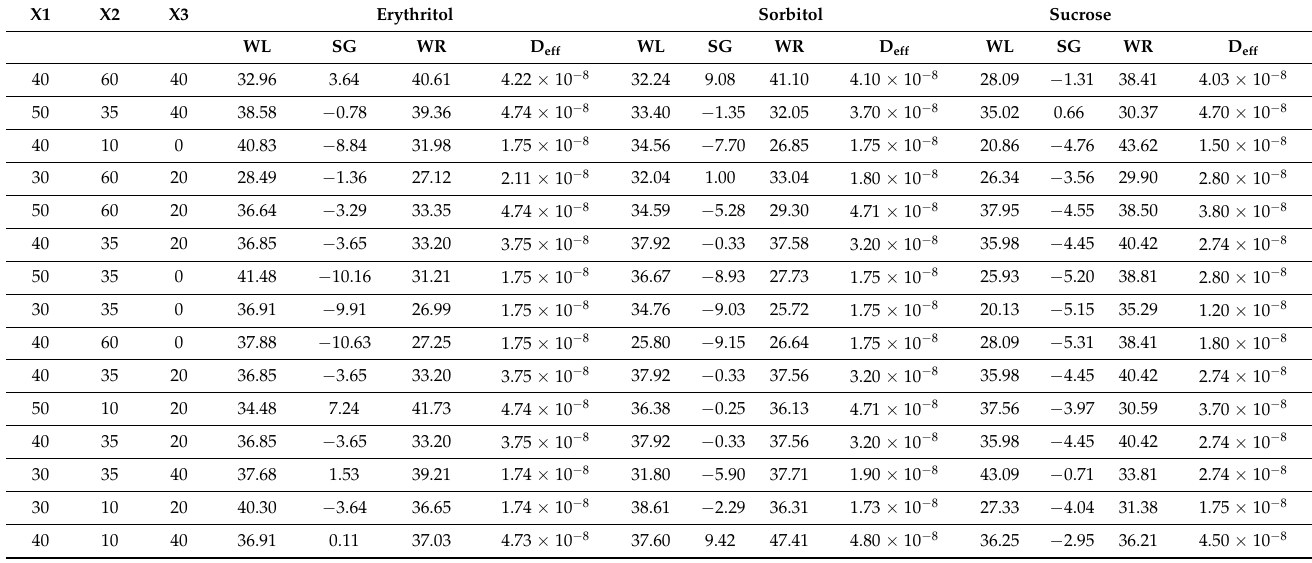
Table 2. Box–Ben design matrix with experimental values of response variables for the OD of pomegranate seeds in different osmotic